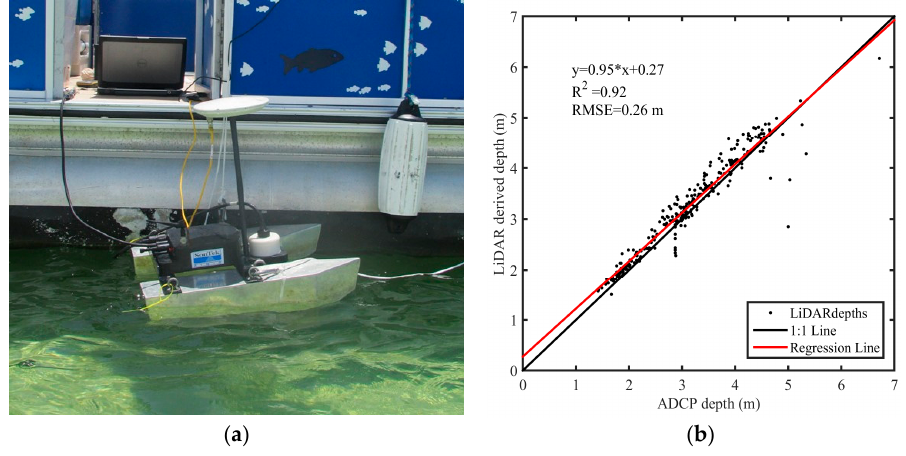
Figure 10. Bathymetric depth accuracy assessment equipment and results. ( a ) Photo of the SonTek acoustic Doppler current profiler (ADCP) and GPS antenna mounted on a small catamaran; ( b ) Dispersion plot showing results from the bathymetric depth accuracy assessment.